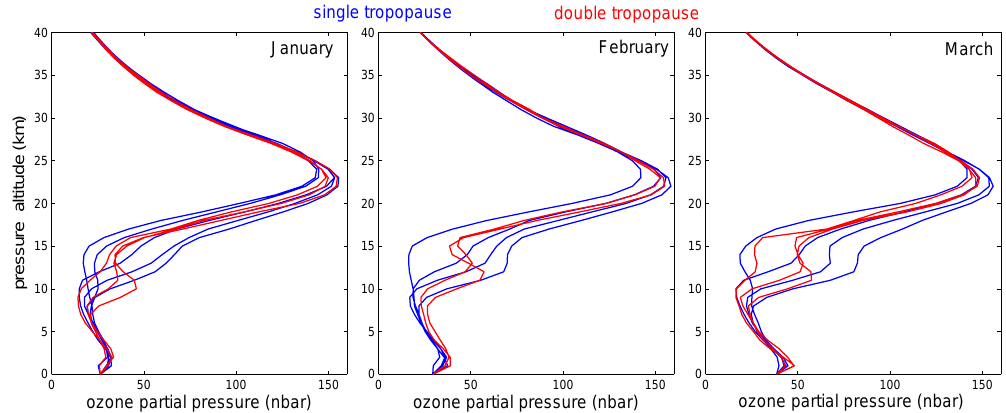
Fig. 13. TpO 3 climatological ozone profiles at 30–40 ◦ N corresponding to double-tropopause (red lines) and single-tropopause (blue lines) temperature